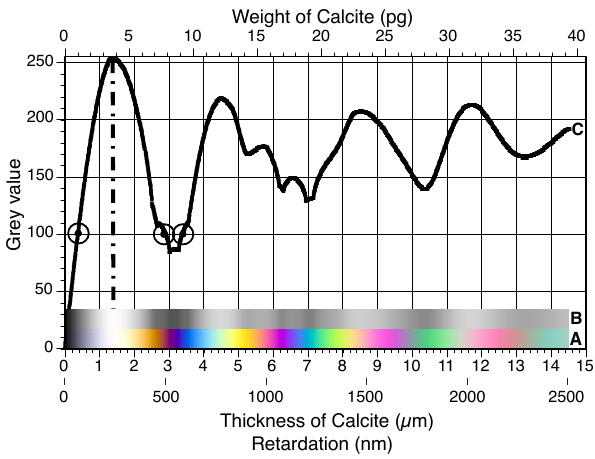
Fig. 1. Relationship between interference colour, retardation, thick- ness and weight of calcite. (A) Michel-Lévy colour chart calcu- lated in 1nm steps retardation after Sørensen (2013); (B) and (C) conversion of the Michel-Lévy colour chart (RGB) into grey val- ues from 0–255 using ImageJ. The thickness and weight of cal- cite were calculated according to Eqs. (1) and (2), respectively. The dashed dotted line ( – (cid:144) – ) indicates the boundary, beyond which, the weight of calcite can not be determined using the relationship be- tween grey values and thickness of a pixel. Marker indicates the different thicknesses/weights for a grey value of 100 assuming a pixel area of 0 . 0225µm 2 : 2 . 9µm ,/ 0 . 177pg; 3 . 4µm / 0 . 207pg or just 0 . 38µm / 0 .